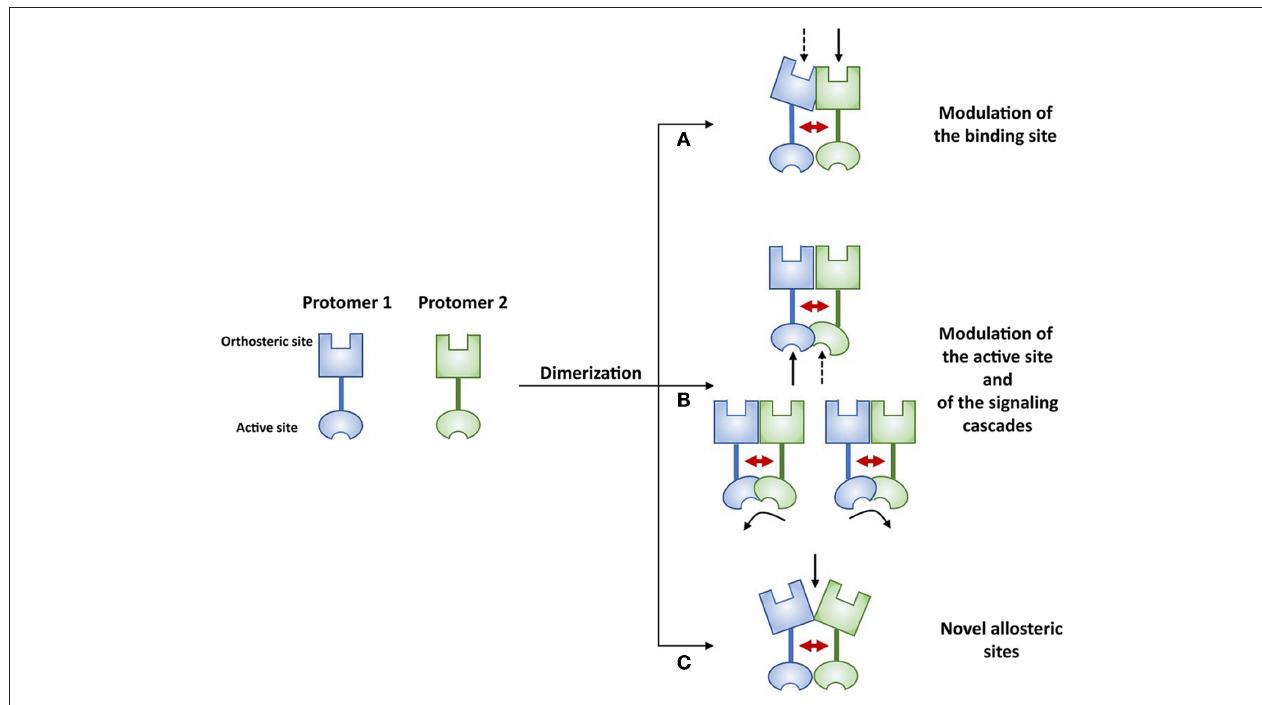
FIGURE 2 | As a result of allosteric RRI, receptor complexes appear to be endowed with pharmacological features that cannot be fully derived from the characteristics of the single participating protomers (see